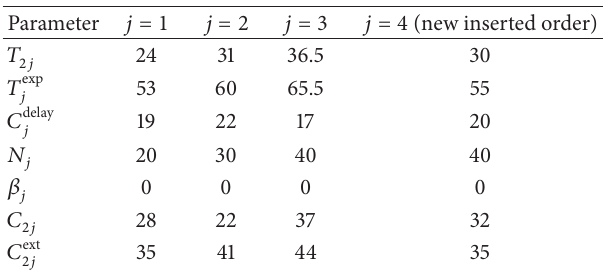
Table 3: Basic data